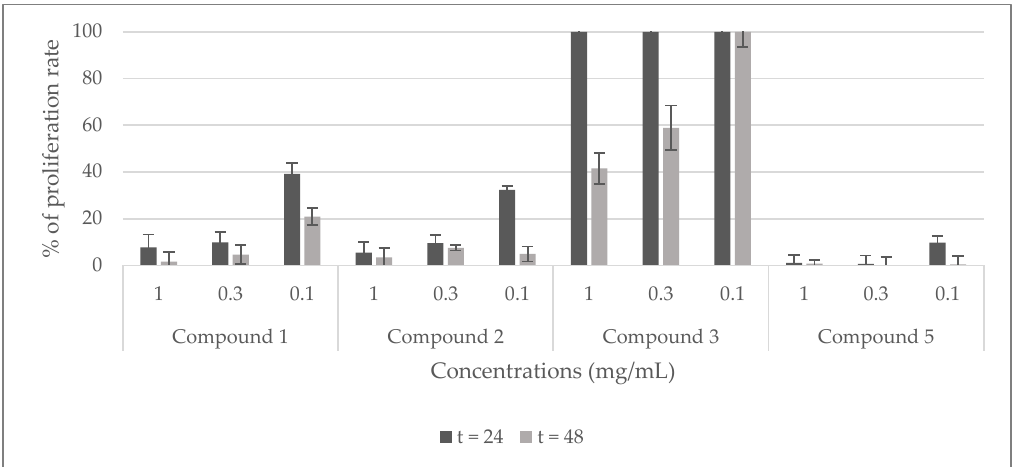
Figure 8. Viability of Hela cells treated with compounds ( 1 , 2 , 3 , and 5 ) isolated from C. villosa stems extracts. All values are expressed as mean of duplicate ± SD.